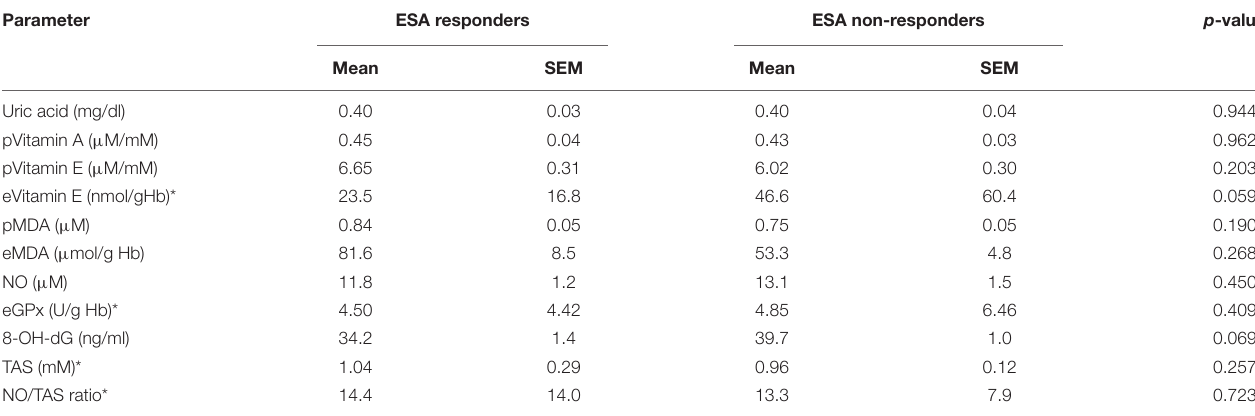
Parameter ESA responders ESA